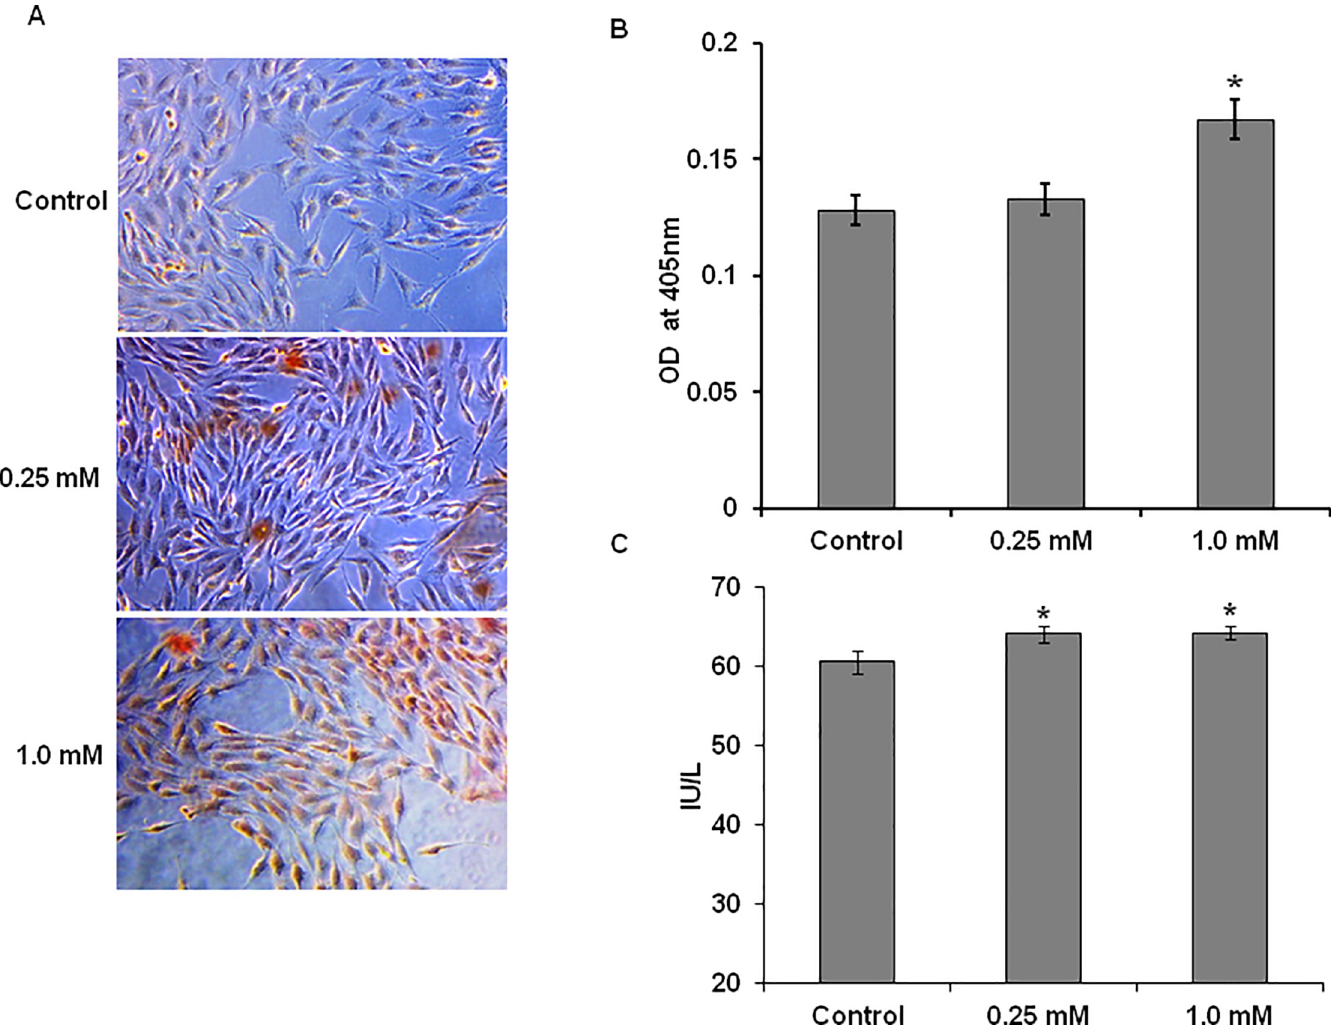
Fig 3. Quantification and visualization of calcium uptake and mineralization in osteoblast-like MG-63 cells. ( A) and (B) represents Alizarin Red S staining and quantification for visualization of calcium uptake and mineralization in osteoblast-like MG-63 cells treated with selected concentrations of calcium glucoheptonate. (C) Changes in the alkaline phosphatase activity reflecting osteogenesis in osteoblast-like MG-63 cells treated with calcium glucoheptonate for seven days.